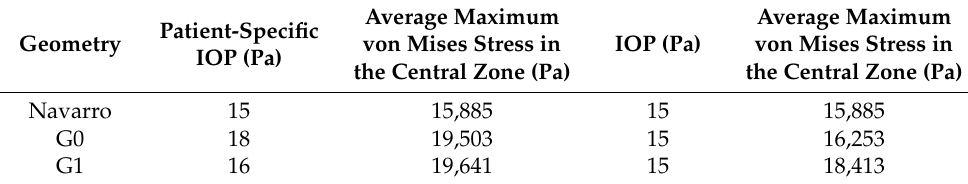
Table 2. Maximum von Mises stress level in central zone of the cornea (Pa).